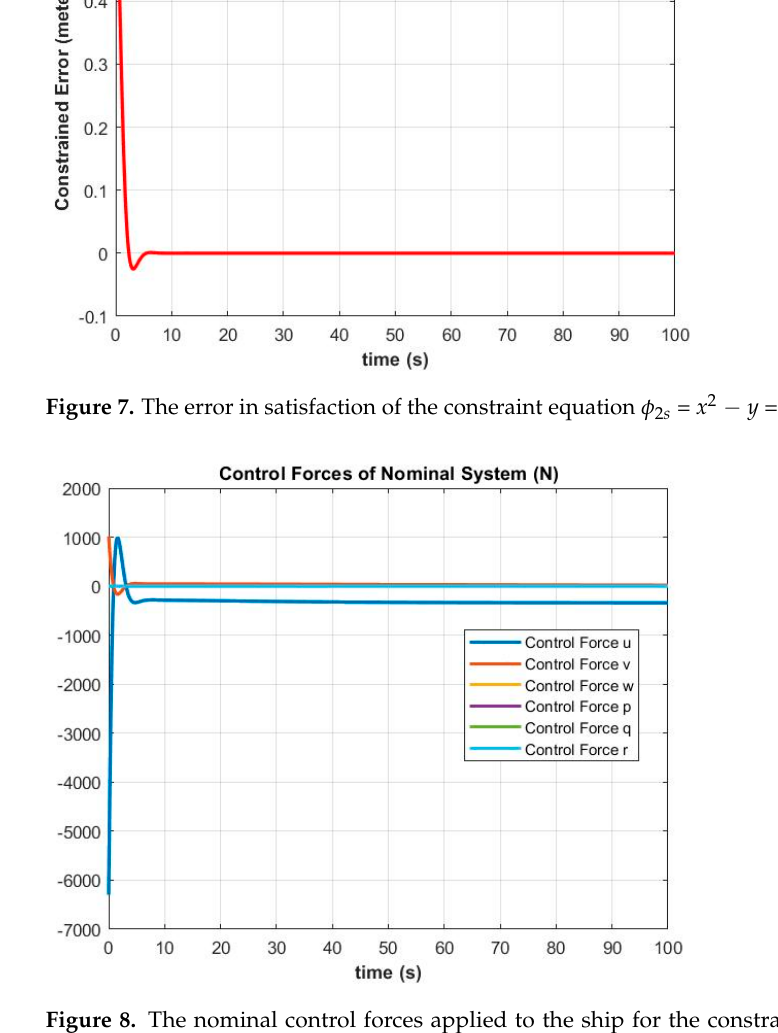
Figure 8. The nominal control forces applied to the ship for the constraint equations ( ϕ 1 s = p d + q d sin ϕ tan θ + r d cos ϕ tan θ = 0) and ( ϕ 2 s = x 2 − y = 0).